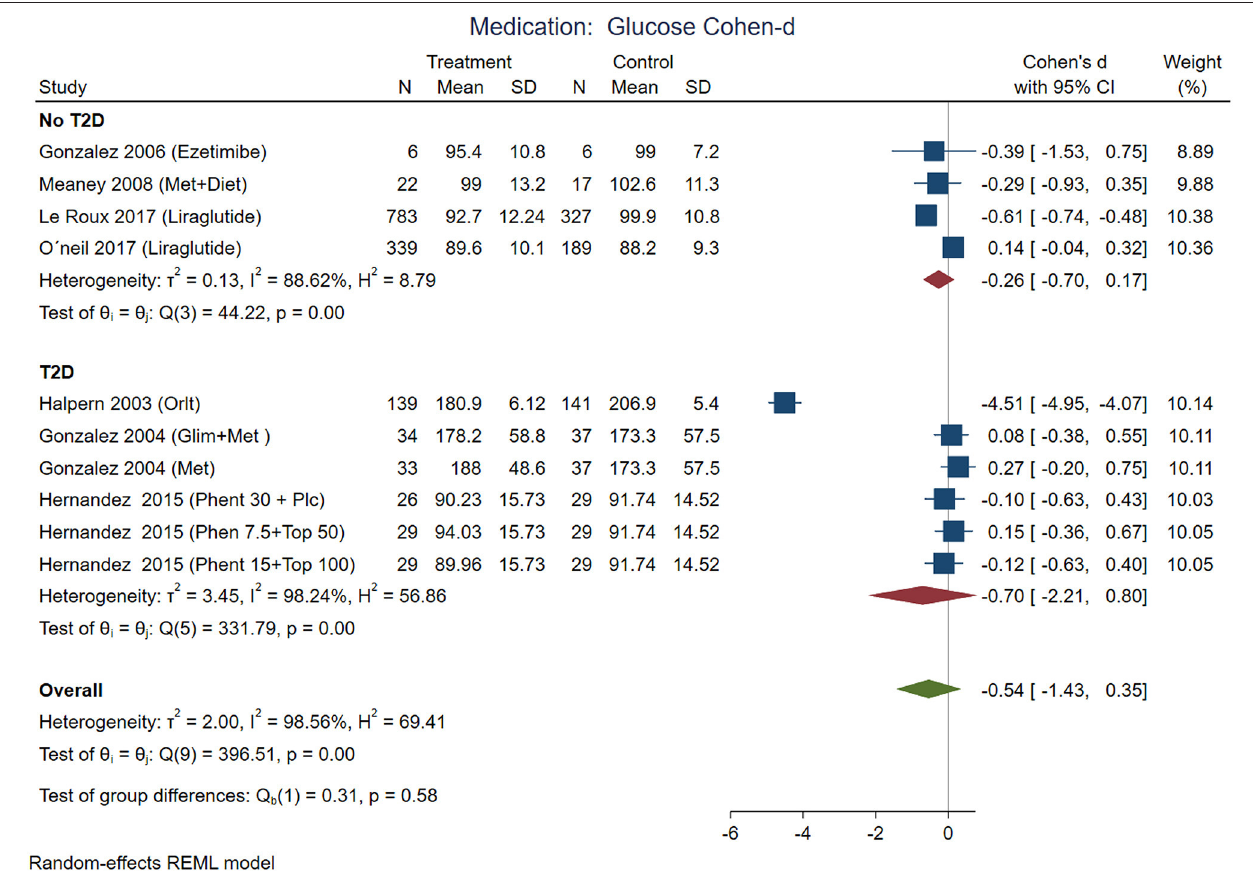
FIGURE 9 | Pooled analysis of Cohen’s d-weighted effect size on serum glucose serum concentration with drug (medication) treatment. The analysis was stratified by T2D status. Met, Metformin; Orlit, Orlistat; Glim, Glimepiride; Phent, Phentermine; Top, Topiramate, REML, Restricted maximum